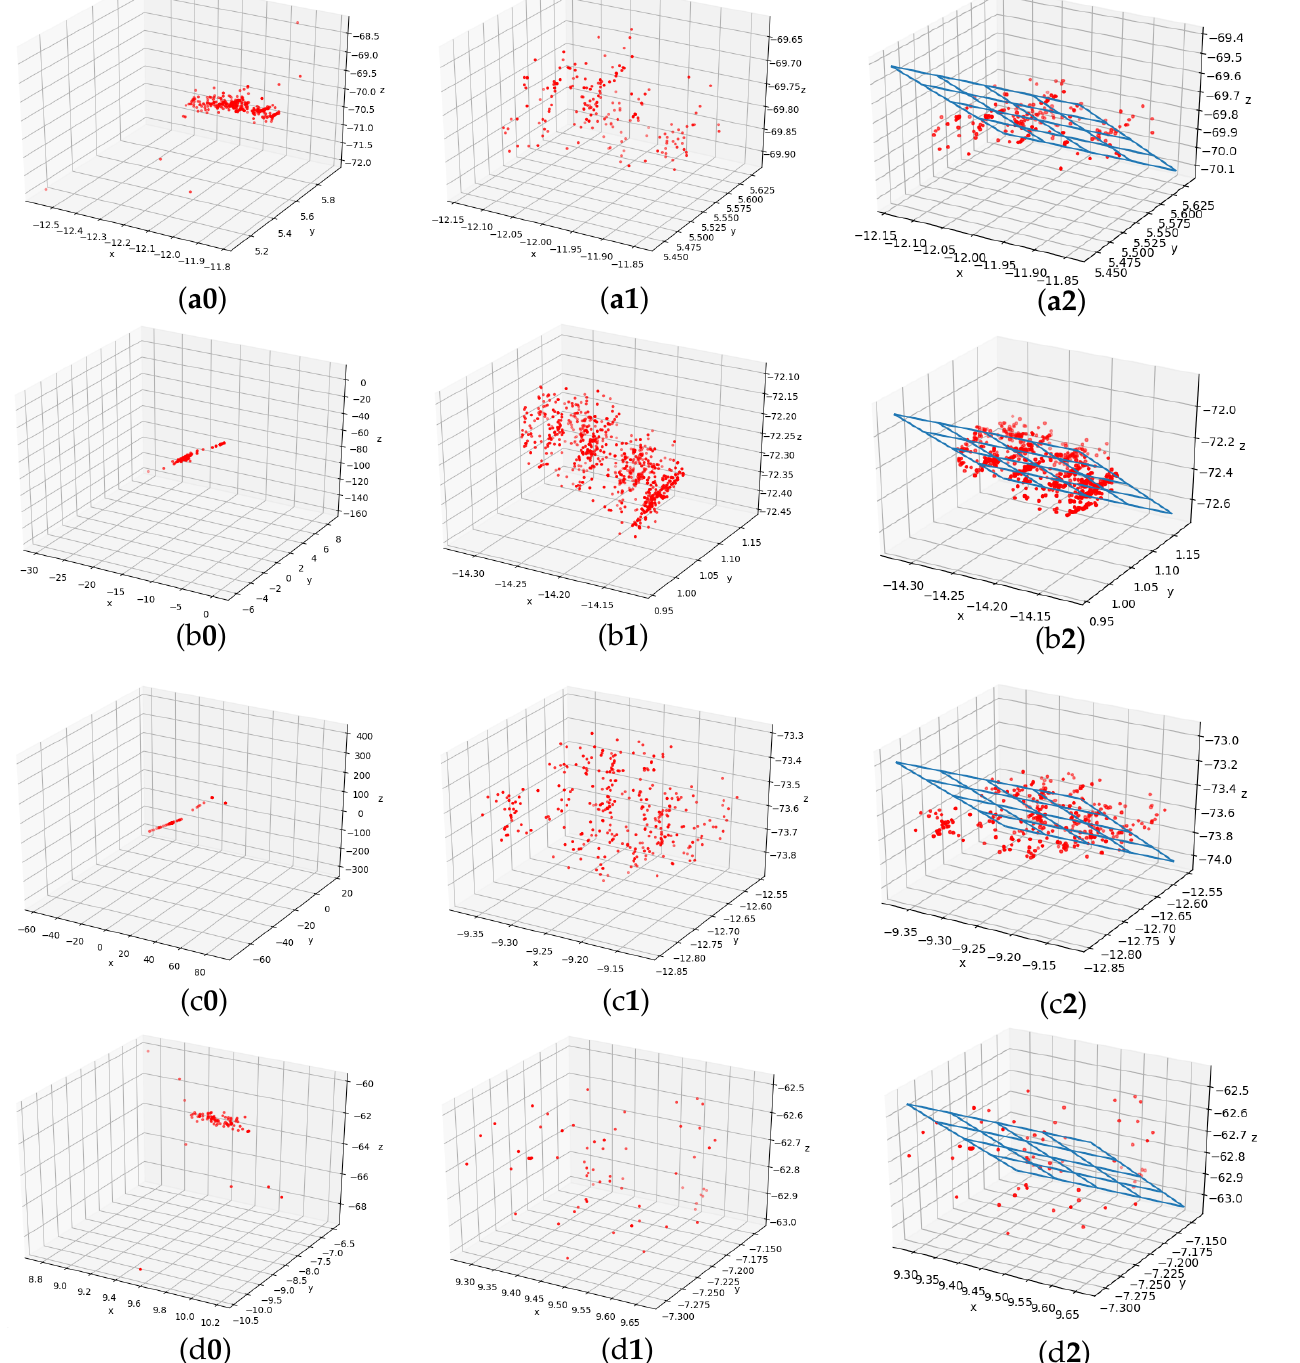
Figure 15. ( a0 – d2 ) The first column is the result of triangulation. The second column is the refined point cloud. Removing outliers to refine 3D localization, the number of adjacent points is set to 50, and the value of Smul is set to 1.0, preserving 75% of the spatial points of the raw point cloud. The third column is the fitted plane using least-squares fitting with the condition that the fitted plane is vertical to the ground surface.